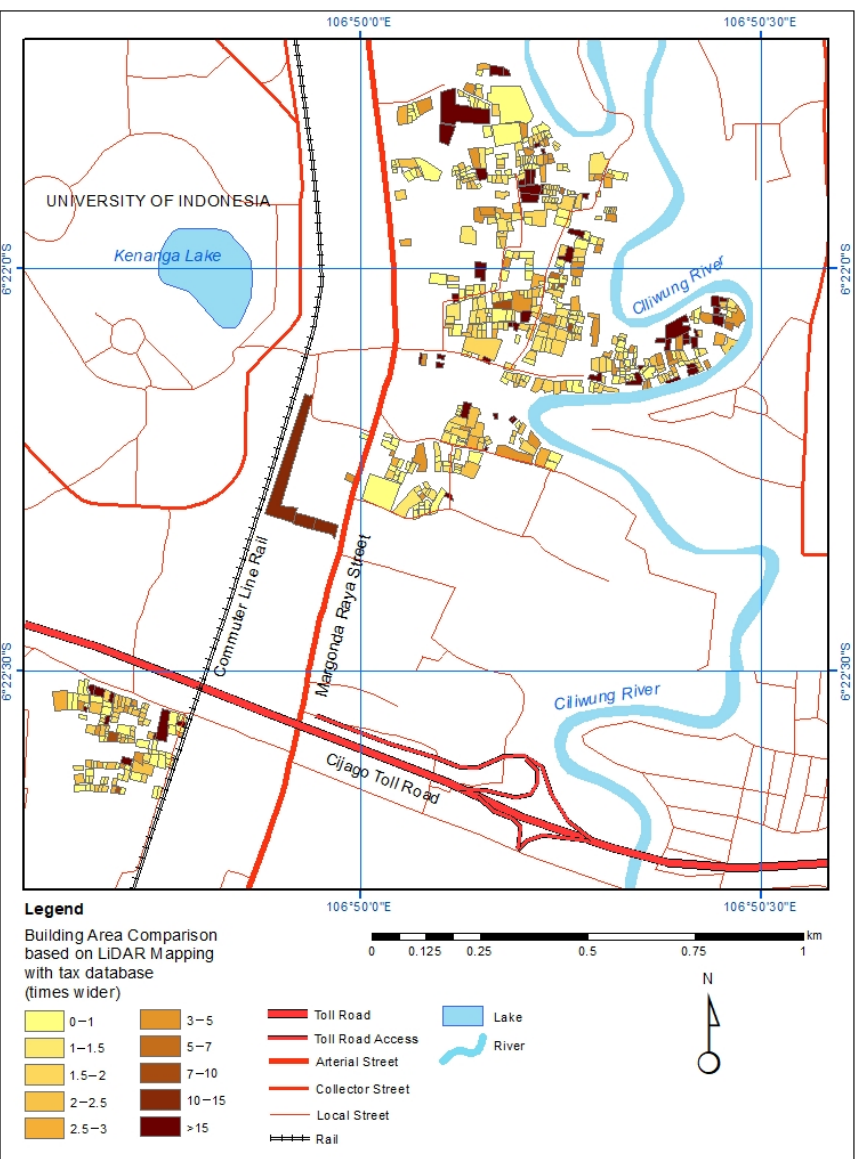
Figure 8. Comparison map of building area based on LiDAR mapping with tax database (source: data processing documentation) .